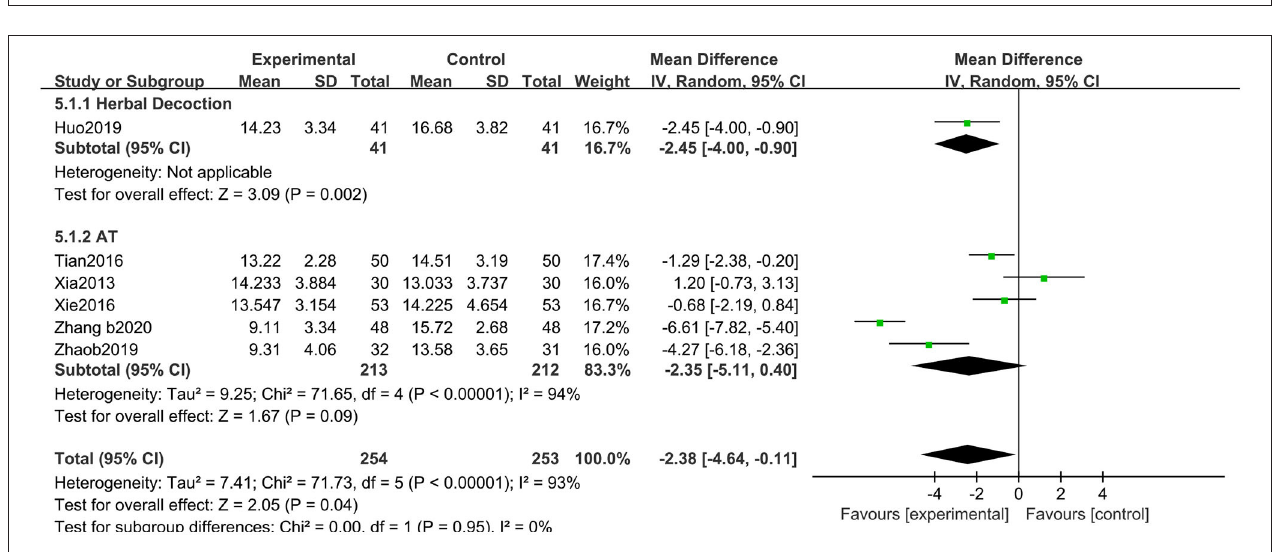
FIGURE 11 | Comparison of acupuncture related therapies in terms of